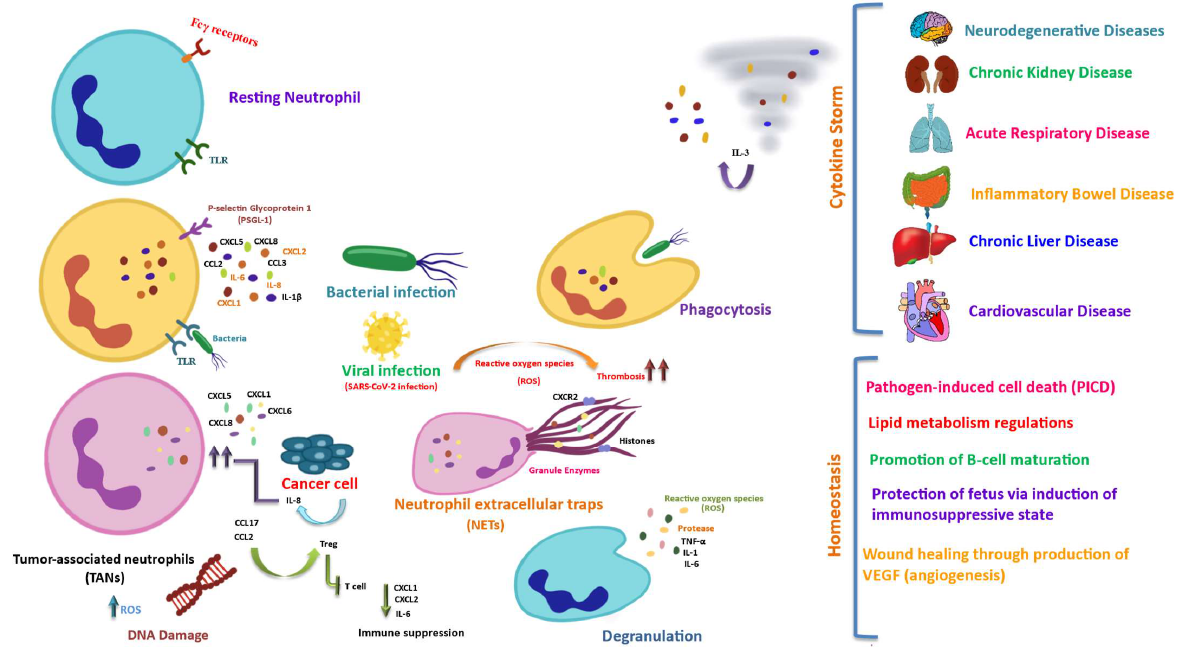
Figure 1. Neutrophils contribute to the pathogenesis of cytokine storm syndrome (CSS). CSS is the discharge of an abnormally high concentration of soluble mediators following the occurrence of an inappropriate inflammatory cytokine response that leads to immunopathological events. It occurs after severe infections, as well as in situations where an inflammatory cytokine response is initiated, exaggerated, but then failed to return to homeostasis. Neutrophils triggered by pathogens (viruses, bacteria, etc.), cancer cells, and autoimmune microenvironmental cues gain the potential to develop CSS.